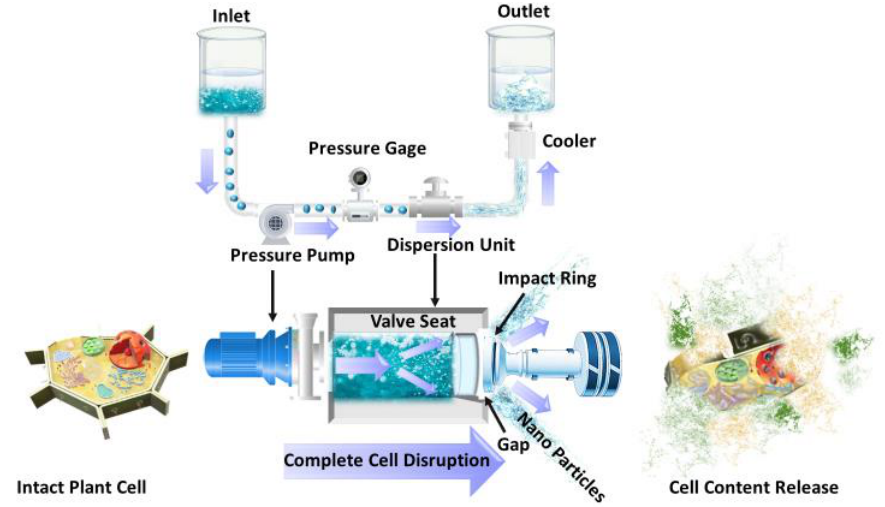
Figure 4. Schematic representation of HPH technology and its effect on plant cell. In 2019, Jurić et al. applied HPH technology ( 1 – 10 passes, at 100 MPa) as a disruption